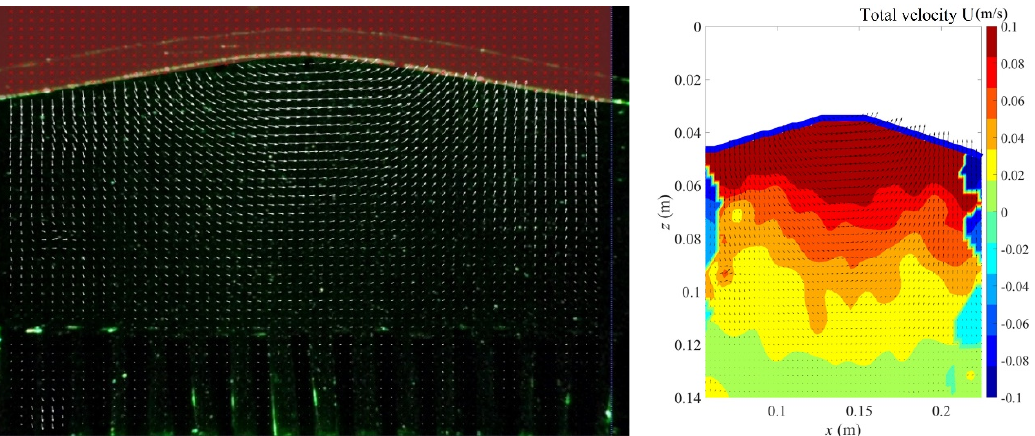
Figure 13. Velocity field and distribution of a short-period wave crest ( T = 0.5 s) passing through vegetation structures ( ϕ = 0.5 cm and d = 5 cm).